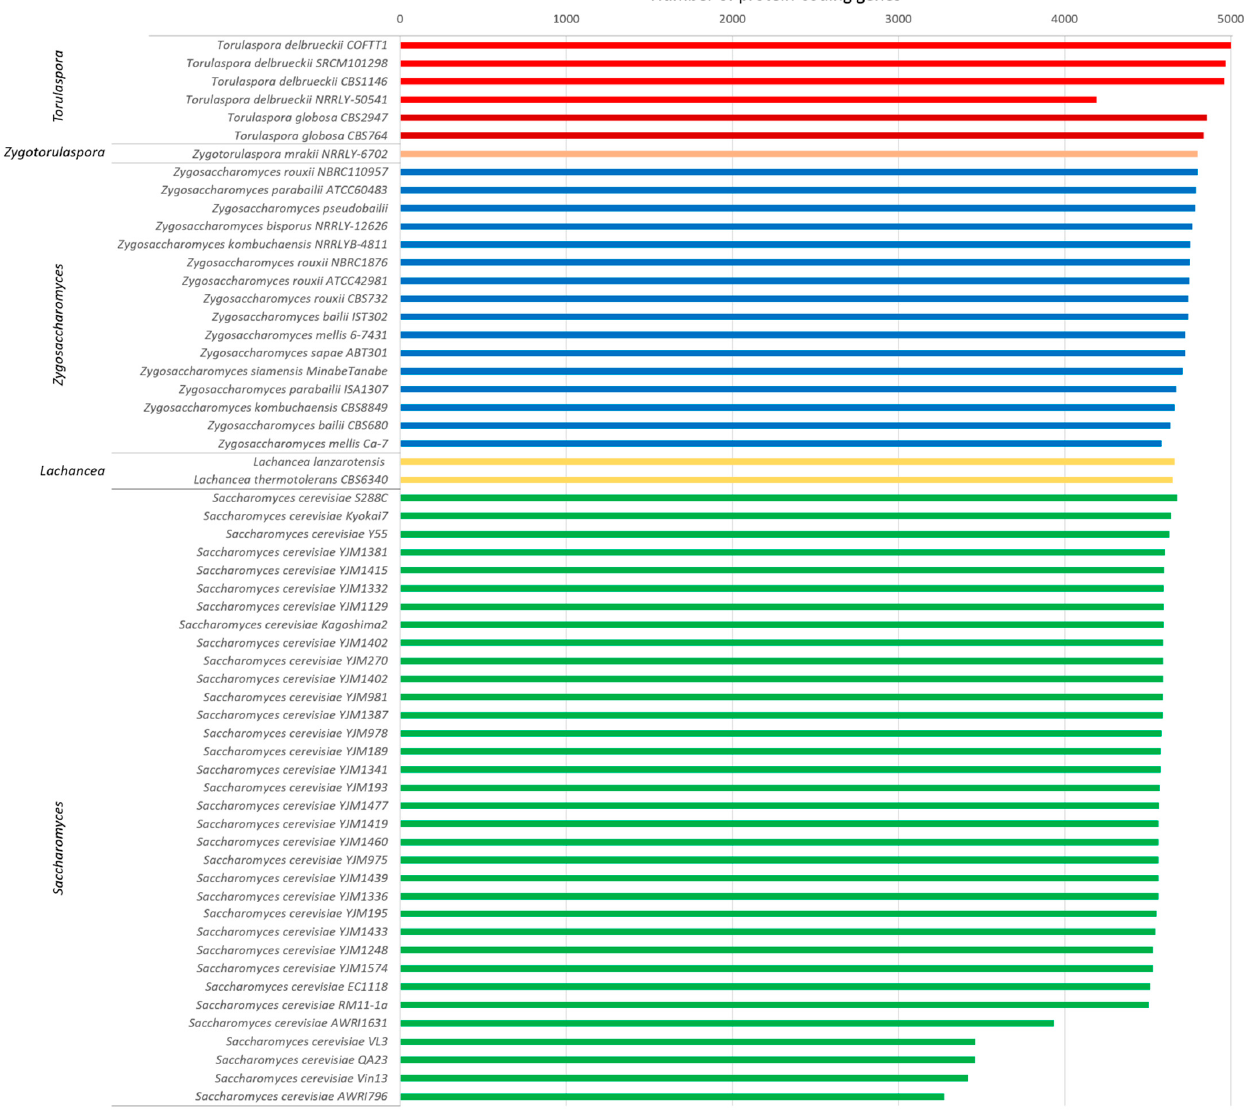
Figure 4. Homology comparison between the protein-coding genes of Torulaspora delbrueckii COFT1 genome (used as the reference) and 56 related yeast species/strains. The protein-coding regions of the COFT1 genome were detected using YGAP and the homology was determined using a BLAST analysis. Only species/strains with more than 4600 homologs are presented (with the exception of some S. cerevisiae strains and T. delbrueckii NRRL Y-50541, which were included for comparison); the results for the complete set of 386 yeasts are available in Supplementary Data S8.